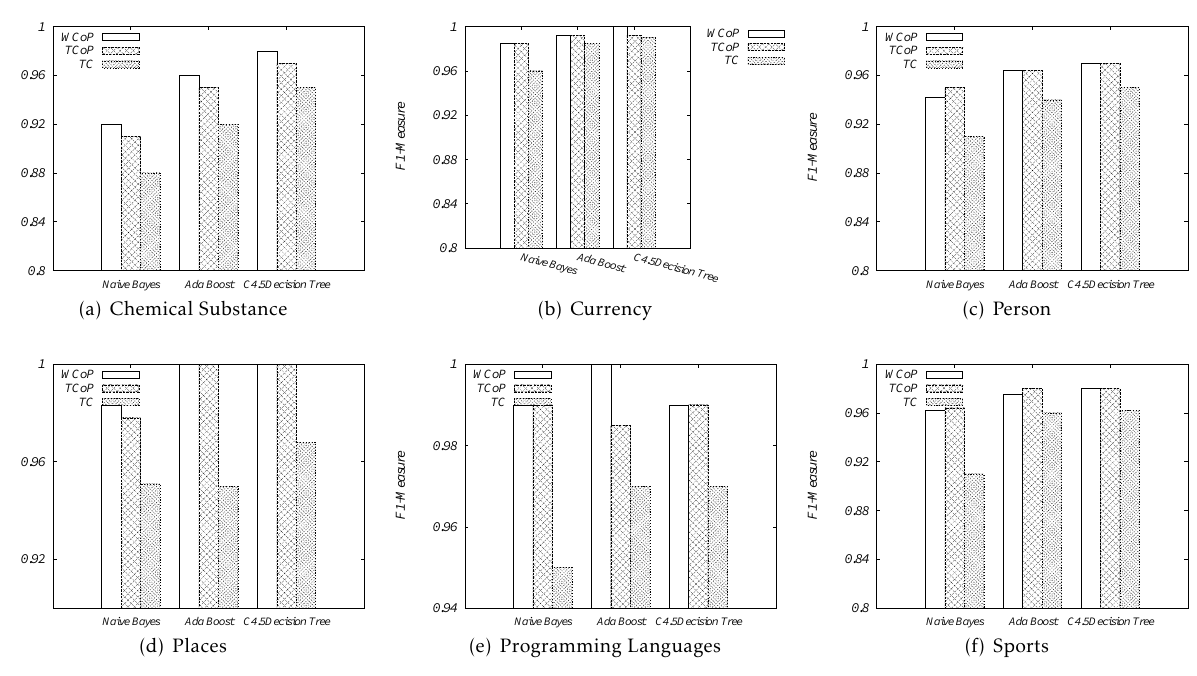
Figure 7. Comparison of WCoP, TCoP and Text Classification Performance on Various Wikipedia Domains